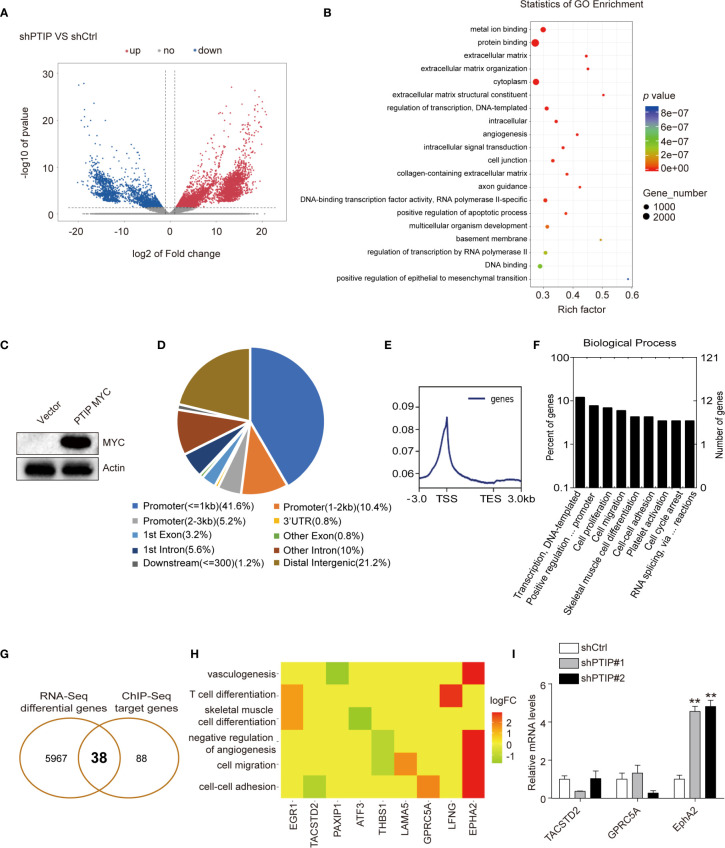
Analysis of the differentially expressed genes(DEGs) and PTIP binding sites. (A) The differentially expressed genes between PTIP knockdown(shPTIP) and control (shScrambled) group were identified by RNA-seq analysis. Volcano plot shows the log2 fold change (x-axis) and significance (−log10 * adjusted p-value; y-axis) with significantly downregulated and upregulated genes shown in blue and red, respectively (adjust P < 0.01 and |log2Foldchange| < 1). (B) Gene ontology (GO) analysis for enrichment of the DEGs based on the results from (A) RNA sequencing. (C) Western blot verification of MYC tagged PTIP over-expression efficiency in TE1 cells. (D–F) PTIP binding sites and target genes were identificated by chromatin immunoprecipitation (ChIP)-Seq using MYC tag antibody in MYC tagged PTIP ESCC cell line. Pie charts showing the distribution of PTIP-binding sites in the genome. The percentage of binding sites are indicated in parentheses. The graphs were generated using the ChIPseeker, Deeptools and GOplot package in R. Binding profile around the transcription start site (TSS) of PTIP (E). Mean read coverage is plotted (y-axis) against a sliding window around the TSS (x-axis). TES, transcription end site; TSS, transcription start site. Enrichment of biological process terms among PTIP target genes(F). (G) Venn diagram showing the overlapping genes identified by RNA-Seq data and ChIP-Seq data. (H) Enrichment of biological process terms among the 38 overlapping genes. (I) qRT-PCR analysis of three potentially PTIP directly regulated cell-cell adhesion genes. Representative images and statistical plots are shown; Mean ± s.d. are given for three independent experiments. One-way ANOVA; **P < 0.01.